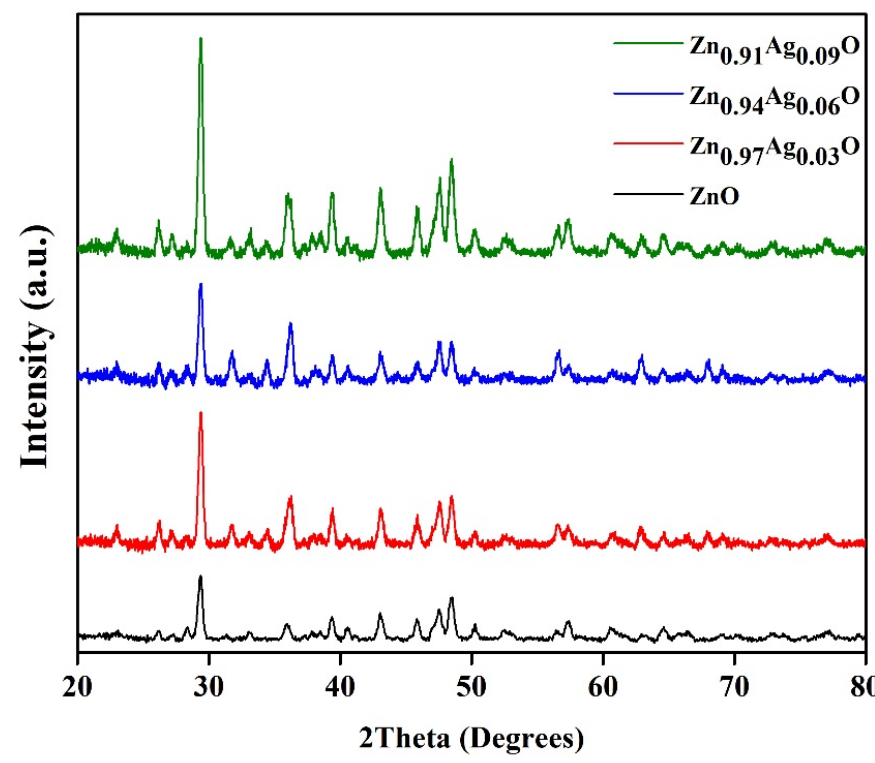
Figure 3. XRD patterns of κ -Carrageenan/ZA-NPs/NaCMC/catechin.